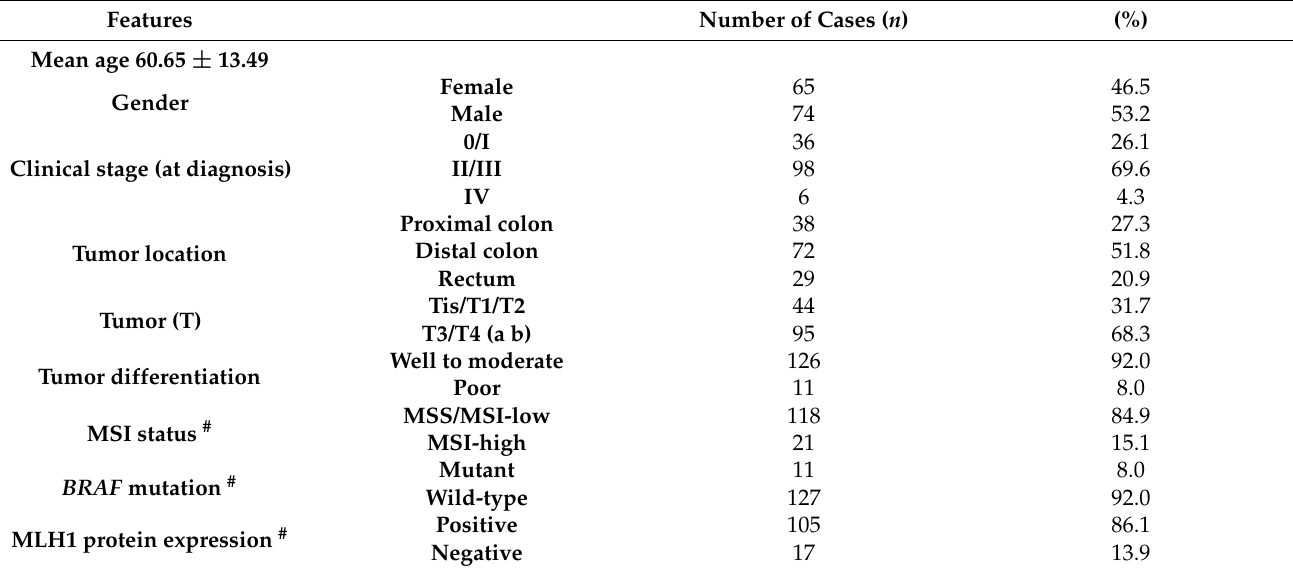
Table 1. Clinicopathological and molecular features of 139 CRC